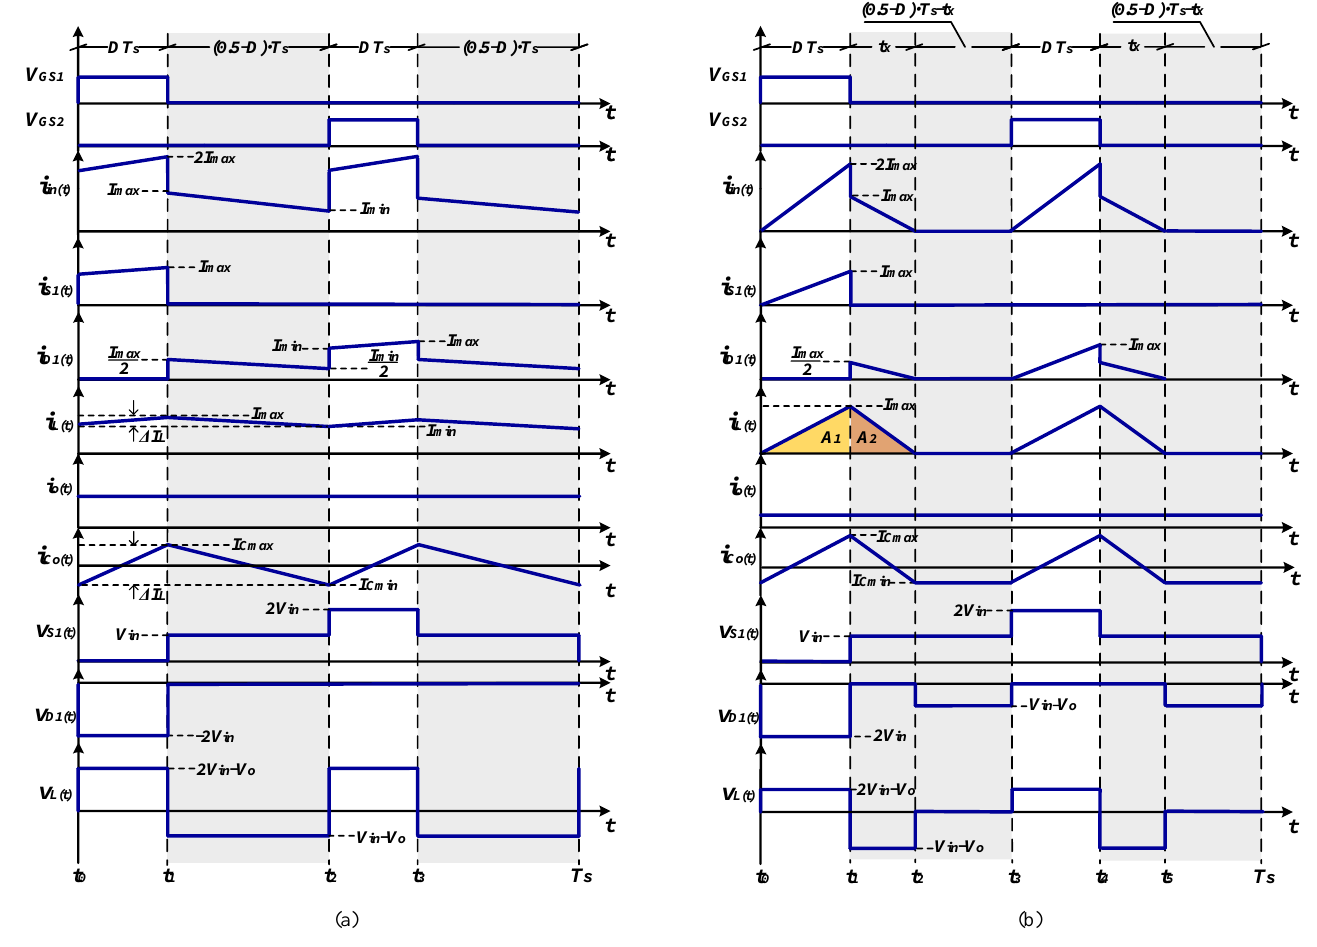
Figure 2. Main theoretical waveforms: ( a ) CCM. ( b )